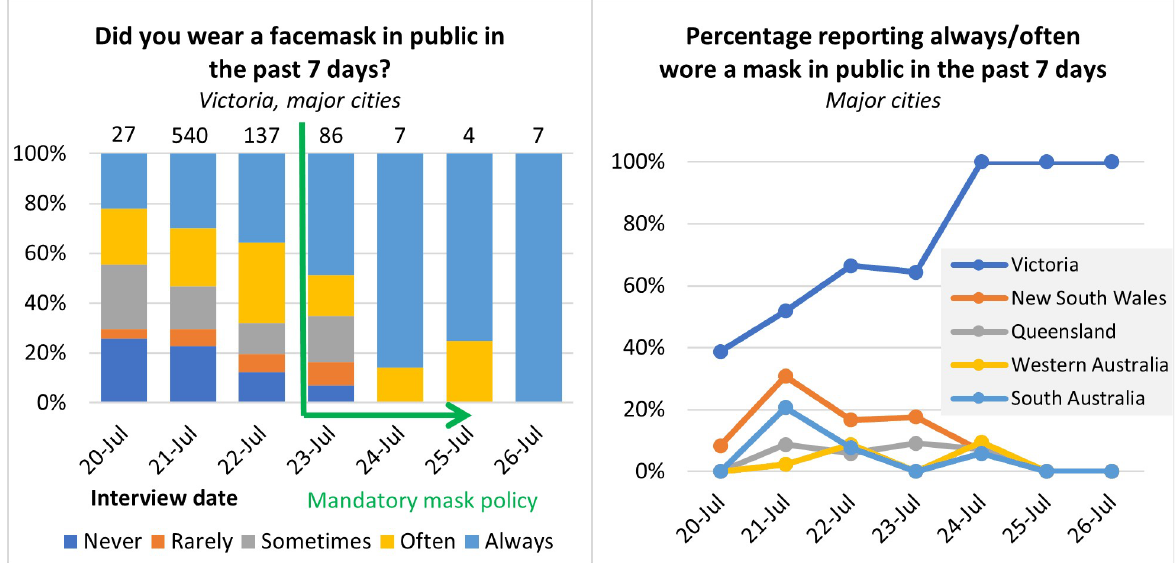
Fig 2. Results from the SCRUB survey. Left: for Round 6 respondents (20–26 July) in Victorian Stage 4 restriction areas, reported frequency of mask use in the past 7 days. Numbers on top of bars represent total respondents. Right: the percentage of respondents who reported always or often wearing a mask over time, Victorian Stage 4 restriction areas and compared to major cities in other states. The number of respondents varied from survey to survey and state to state but averaged 38.6 for each state and time point and the details are listed in S1 File.